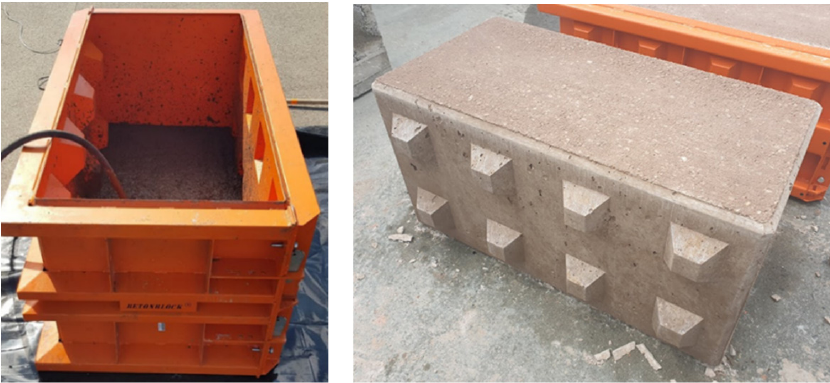
Figure 4. Concrete placement during the first semi-operational tests and concrete blocks.